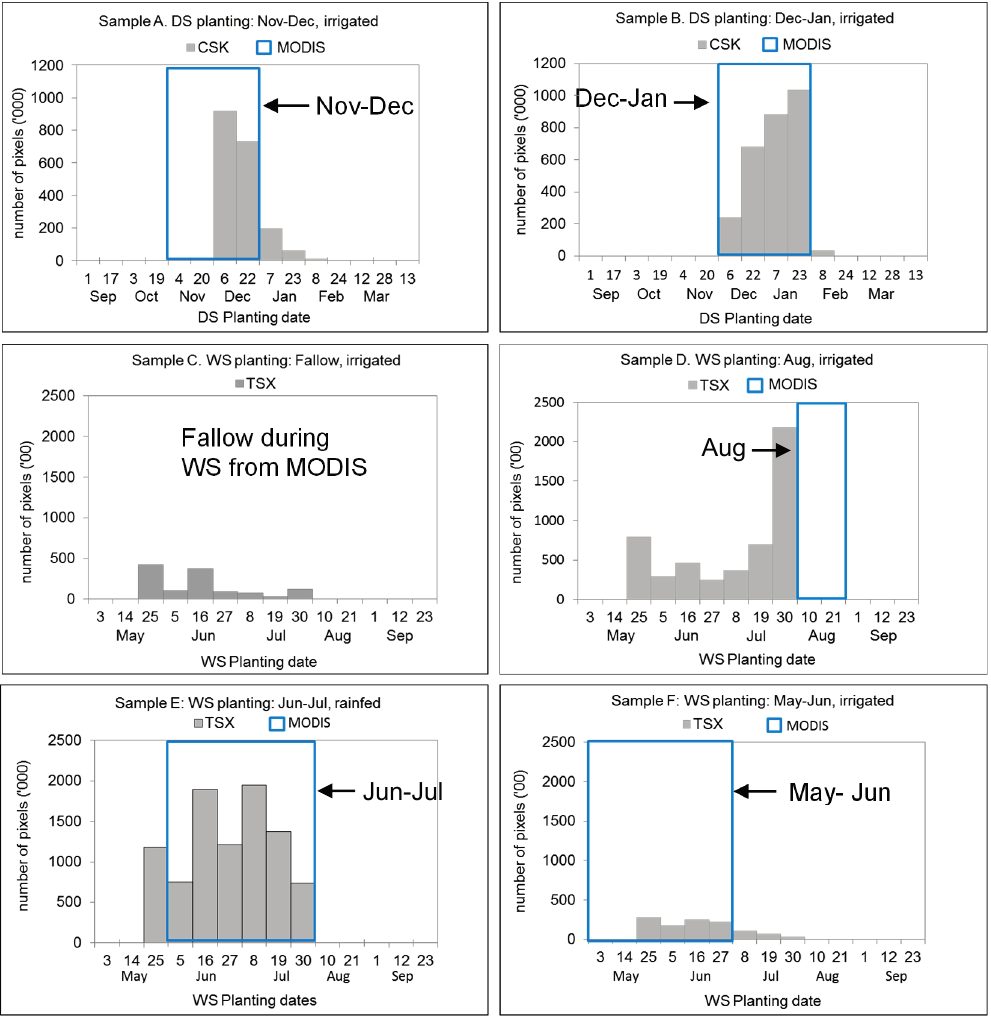
Figure 10. Examples of planting period from different rice cropping systems acquired from MODIS (blue box) and SAR (gray columns) for the DS and